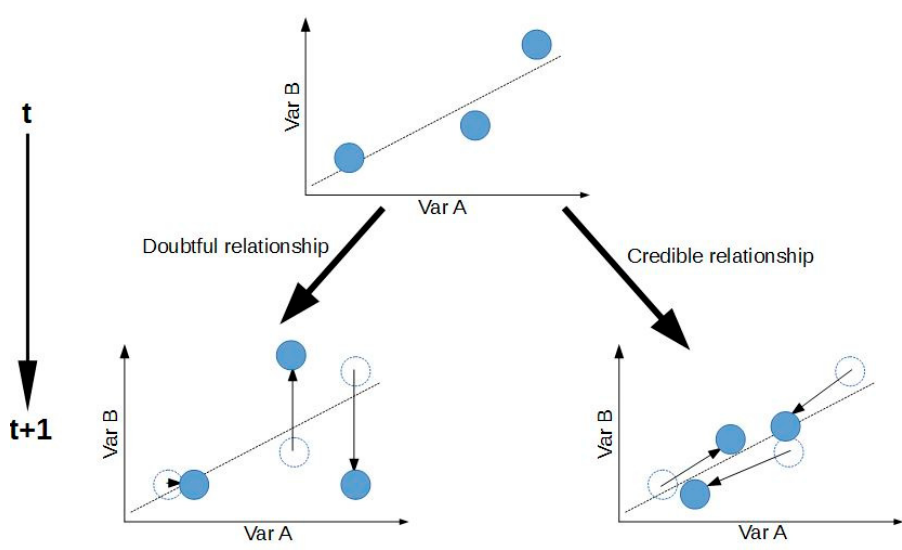
Figure 2. Credible vs. doubtful relationships between variables A and B in time. At time t, samples are illustrated by blue circles, each corresponding to a determined sampling site. At time t+1, they change to the direction indicated by the arrow. The associated linear regression for each date t is represented by a black dotted line, assumed to be stable over time. On the contrary, the individual trajectories of each sample are very different between both scenarios (left vs. right). In the first case (left), the trajectory for each site strongly differs from the linear regression, while in the second case (right), each trajectory closely follows the regression line’s trend, whether increasing or decreasing, suggesting a consistent relationship between both variables.